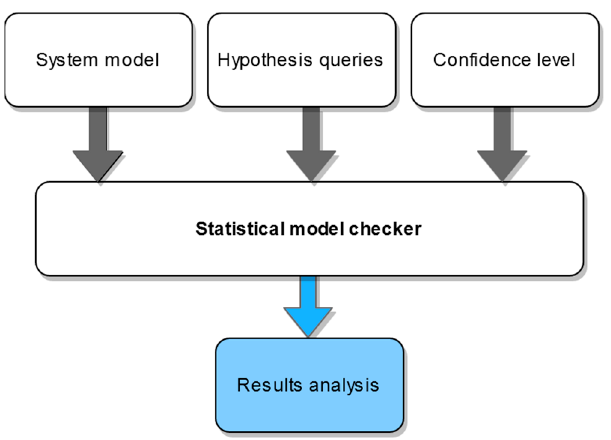
Figure 6. Process of statistical model